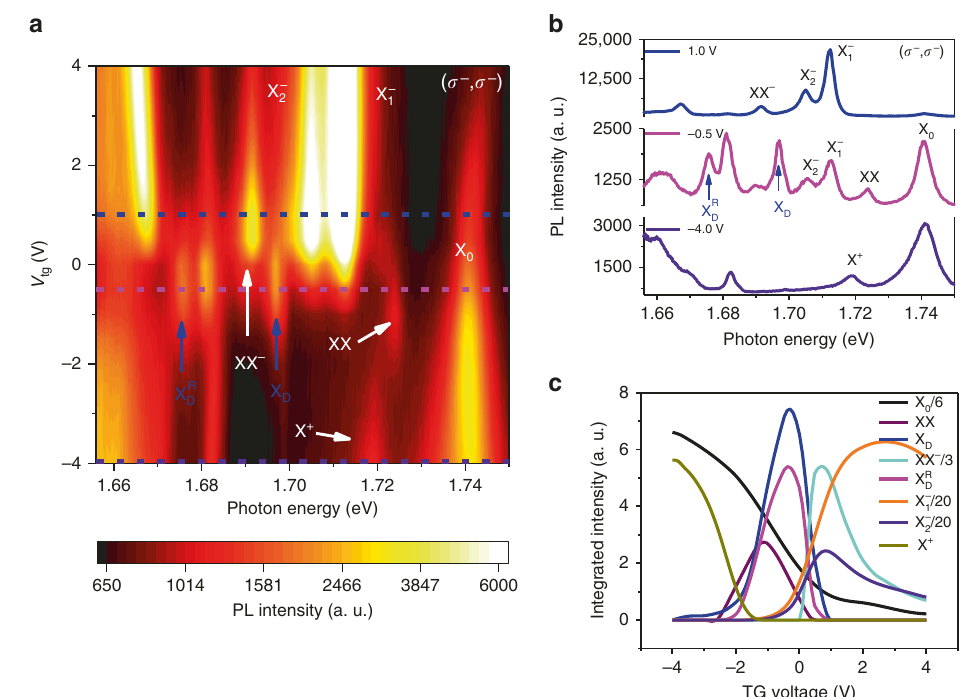
Fig. 3 Gate-dependent PL intensity of the dark-exciton and its replica. a PL spectra at 4.2 K as a function of the top gate voltage for a second BN encapsulated monolayer WSe 2 device. The color represents the PL intensity. The excitation is a CW laser centered at 1.959 eV with an excitation power of 40 µ W, under which the biexciton (XX) and the charged biexciton (XX − ) are also visible. The gate dependence of the dark exciton replica X R that of the dark exciton. b The line traces from ( a ) for the gate voltages of 1.0 V (blue), − 1.0 V (magenta) and − 4.0 V (purple). c Integrated PL intensity for different exciton complexes as a function of the gate voltage. The non-zero PL intensity regions for the dark exciton and its replica are almost identical, from ~ − 2.1 V to ~0.9 V of the top gate voltage